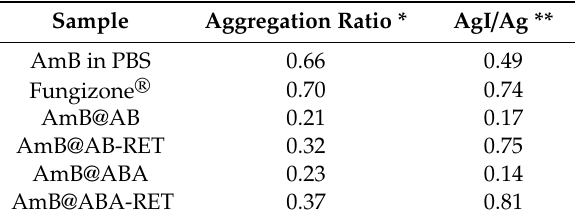
Table 5. Summary of UV-vis spectrum analysis.